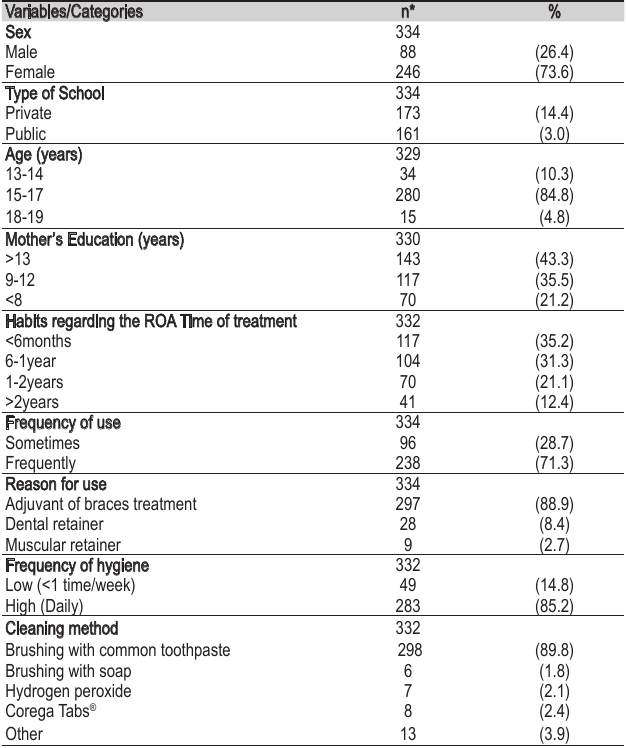
Table 2 - Socio-demographic and behavioral